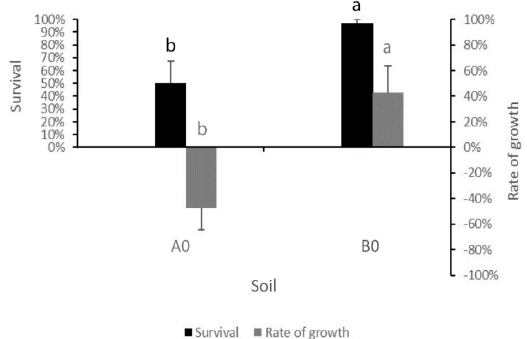
Figure 3. Average and Standard Error of the percentage of surviving earthworms and of the rate of growth in soil A and B after 28 days. Di ff erent letters above bars mean significant di ff erences between A0 and B0 ( p ≤